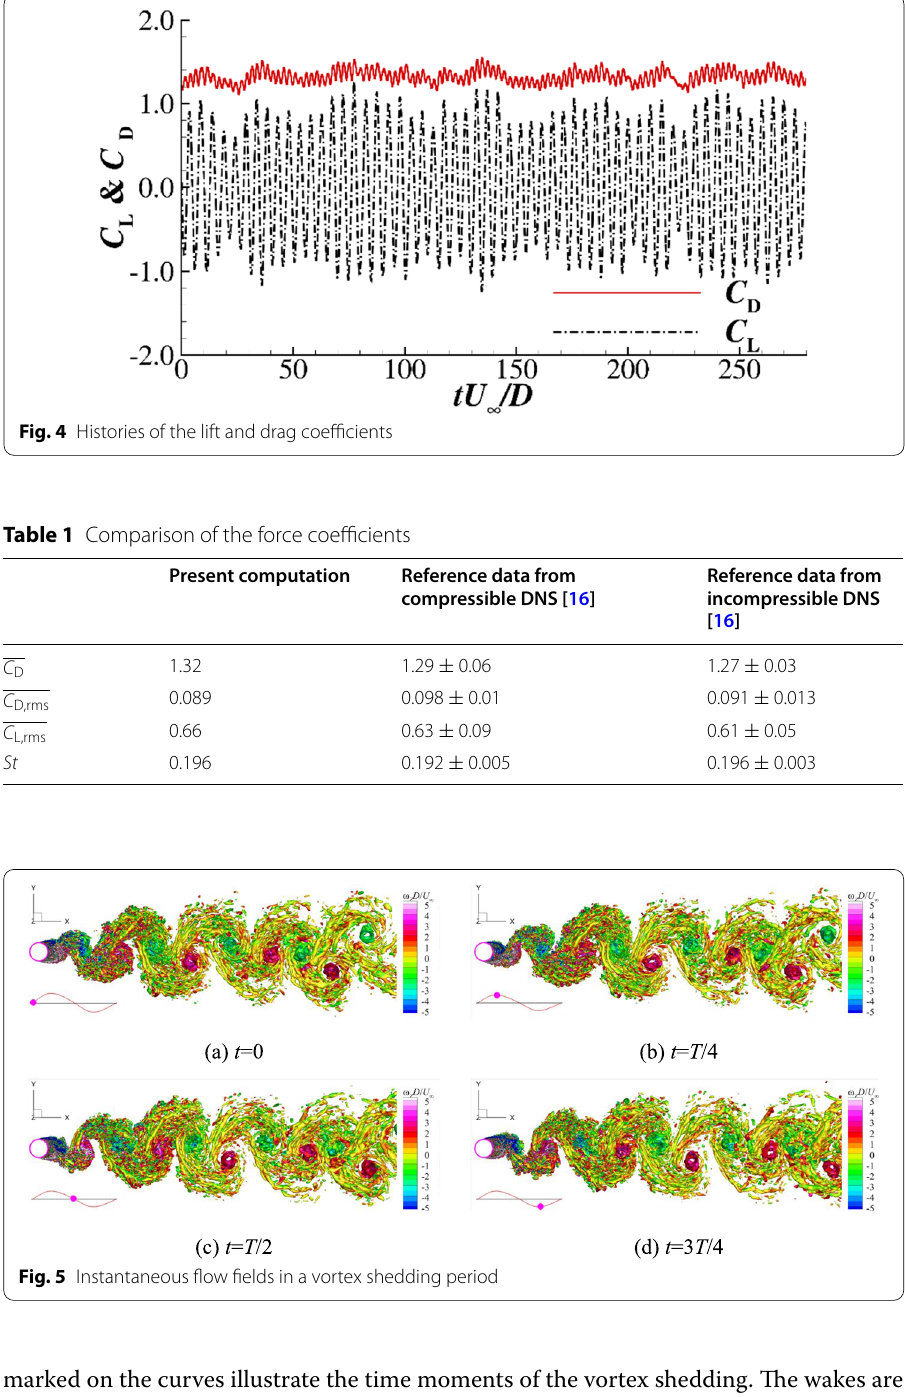
) 2 0.8, with the color = ∞ . The Reynolds number was ∞